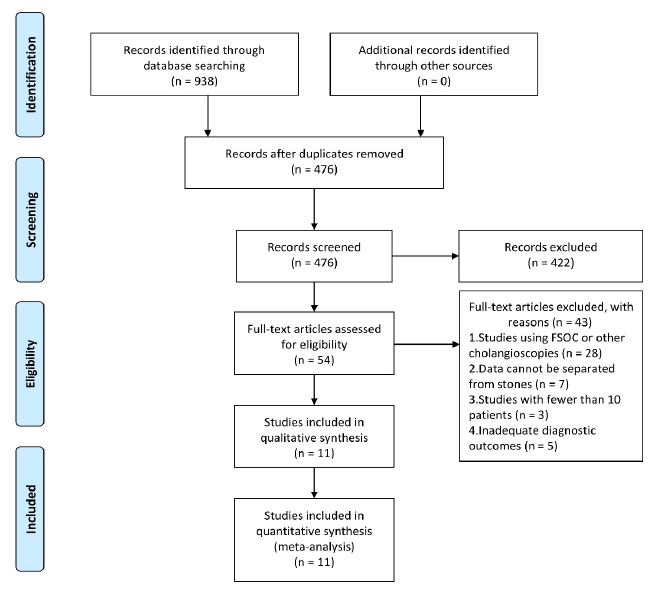
Figure 1. The flow diagram shows the selection process according to the PRISMA statement.